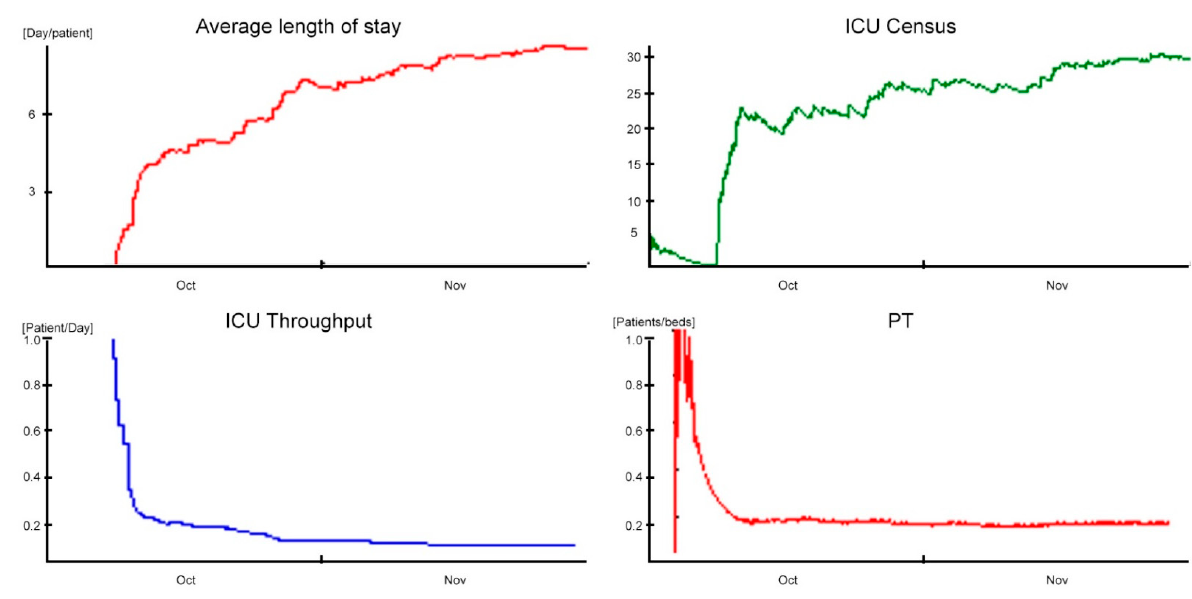
Figure 6. Outcomes in baseline scenario.